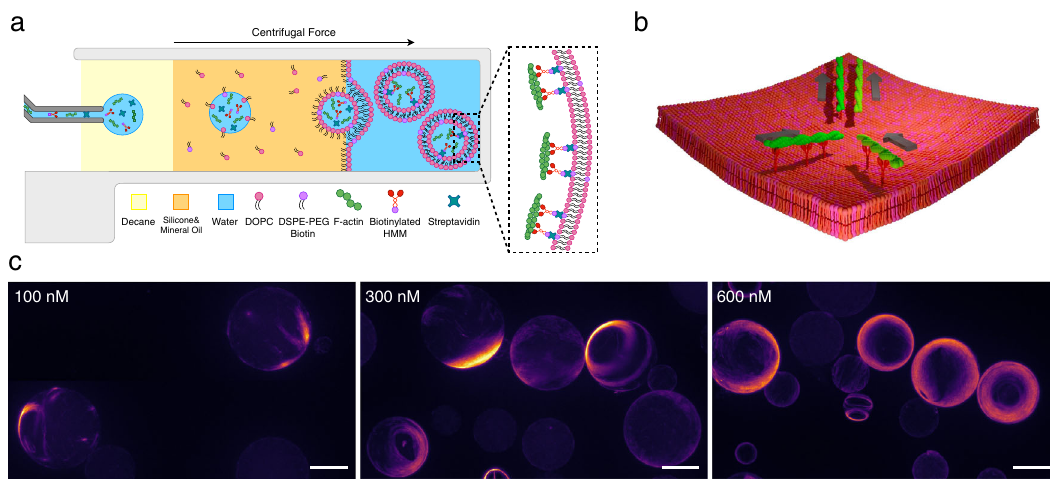
Fig. 1 Encapsulation of active actin fi laments in giant unilamellar vesicles. a Schematic of the vesicle production process. The protein mixture containing F-actin, biotinylated HMMs, and streptavidin is encapsulated inside giant unilamellar vesicles (GUVs). b Schematic of a collision of two actin fi laments on the inner lea fl et of a GUV. The two fi laments have a strong tendency to align after the collision due to the stop-and-go interaction. c Fluorescence images (z-projections) of GUVs with encapsulated actin concentration at 100, 300, and 600 nM. Scale bars, 20 μ m.